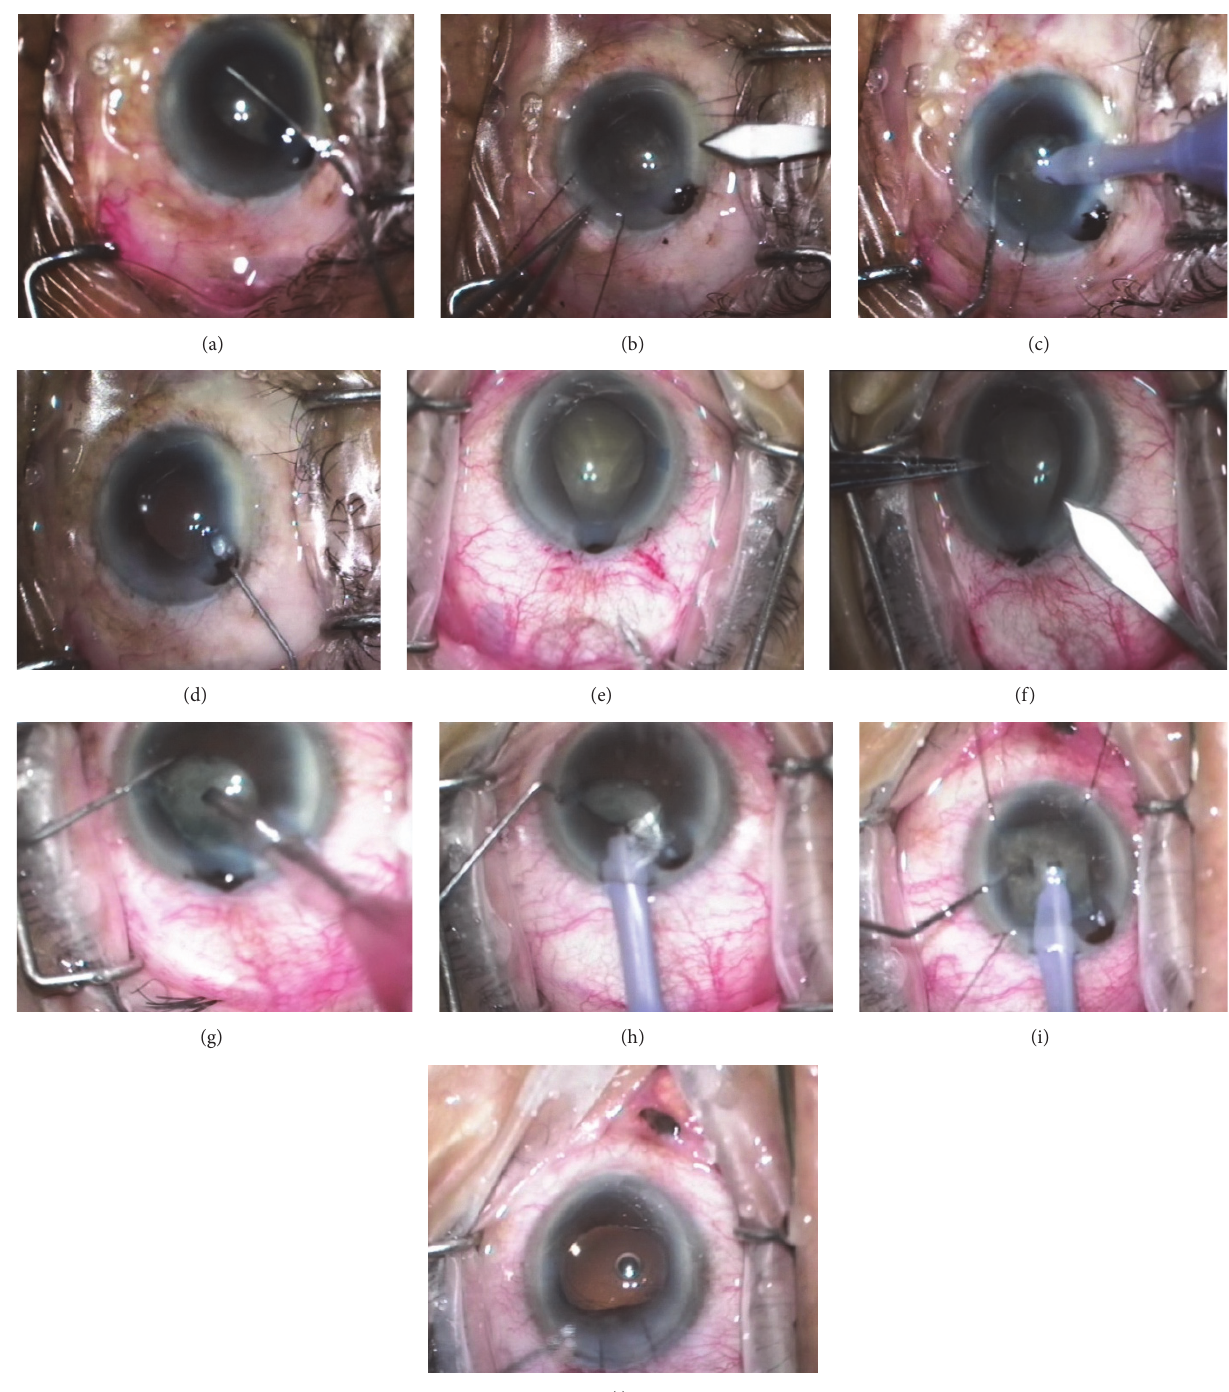
Figure 1: Photographs demonstrating our surgical technique to manage IFIS. In Patient 1, the iris prolapsed during hydrodissection and hydrodelineation (a). Prolapsed iris was left incarcerated in the first incision. Two iris retractors were placed to ensure adequate pupil size and the second main incision was made at 12 o’clock (b). Phacoemulsification was continued via the new superior incision (c). Prolapsed iris tissue was repositioned with OVDS after IOL implantation and OVDS removal (d). In Patient 2, during hydrodissection, the iris prolapsed throughthemainincision,similartoPatient1(e).Thesecondmainincisionwascreatedlateraltotheoriginalincision(f).Phacoemulsification was attempted via the new incision but the pupil started to constrict (g). Phacoemulsification was then performed via the original main wound instead, leaving the iris prolapsed through the second main wound. Nonetheless, the pupil was getting more constricted (h). Three iris retractors were placed and the surgery was continued without further complications (i). Each main wound was sutured at the completion of surgery